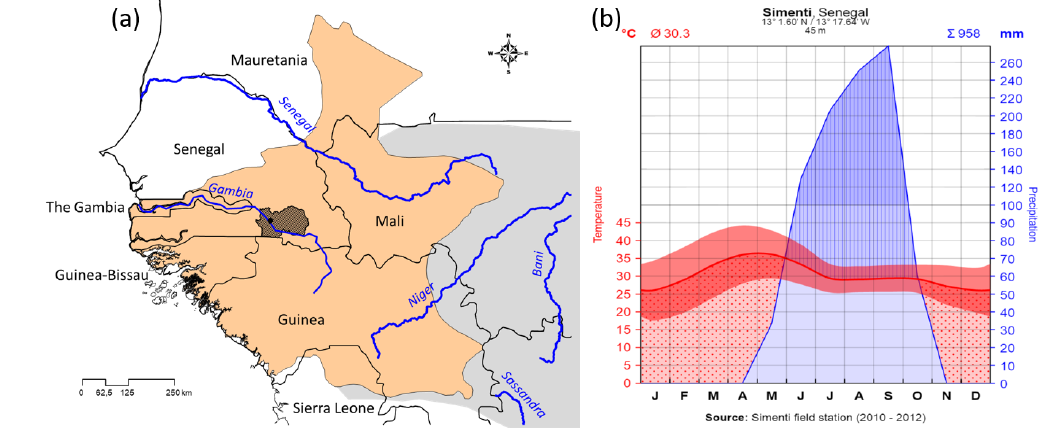
Figure 2. (a) Approximate distribution of Guinea baboons (brownish) and position of CRP Simenti within the Niokolo-Koba National Park (PNNK, dark shading). Species distribution after Wallis et al. (2020) and derived from the IUCN spatial database (https://www.iucnredlist. org/resources/spatial-data-download, last access: 19 January 2021). (b) Climate graph of the Simenti field site after Walter and Lieth (1967). Depicted are monthly temperatures (red line denotes mean; red band the min, max) and monthly precipitation (blue) in millimetres. Red dotted area demarcates the dry periods (i.e. dry season), the blue area depicts the occurrence of precipitation, and the blue hatched area the humid periods (i.e. rainy season).